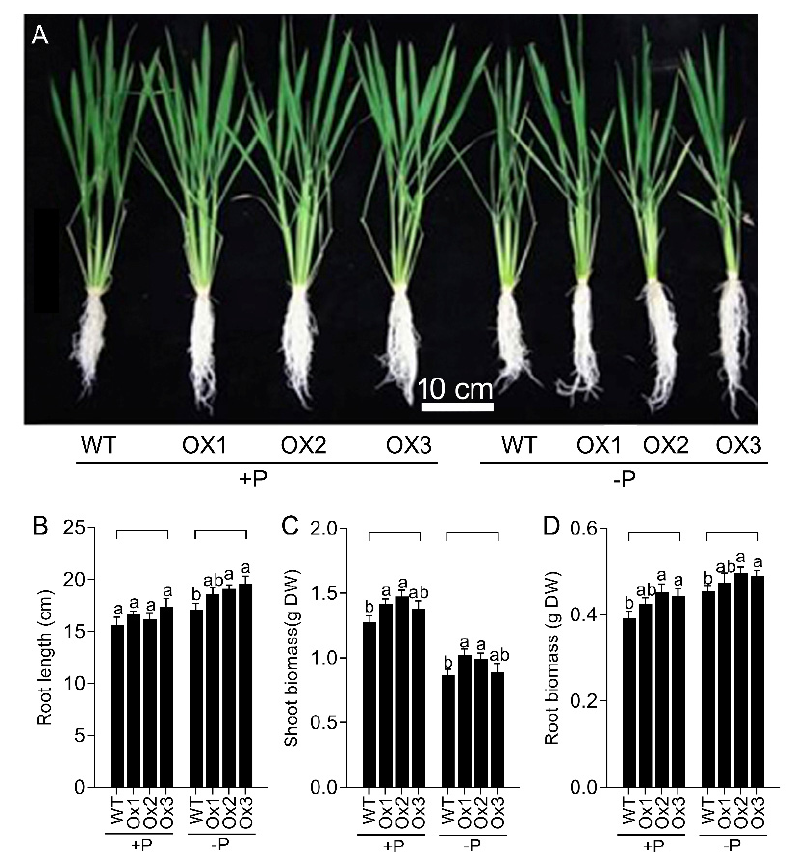
Figure 2. Overexpression of OsPHT1;4 promotes rice vegetative growth. WT and OsPHT1;4 -Ox lines (Ox1–Ox3) were grown hydroponically in ( A ) +P and − P media for 3 weeks. ( A ) Morphological comparison of WT and Ox1–Ox3 plants grown under +Pi and − Pi regimes. Comparisons of primary root length ( B ), shoot biomass ( C ), and root biomass ( D ) of the Ox plants and WT control. DW: Dry weight. Values are means ± SE ( n = 5). Different letters above the bars indicate significant differences ( p < 0.05, one-way ANOVA).